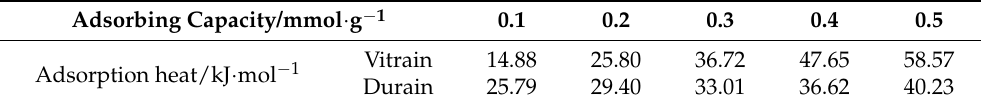
Table 8. Isosteric adsorption heat during methane adsorption.